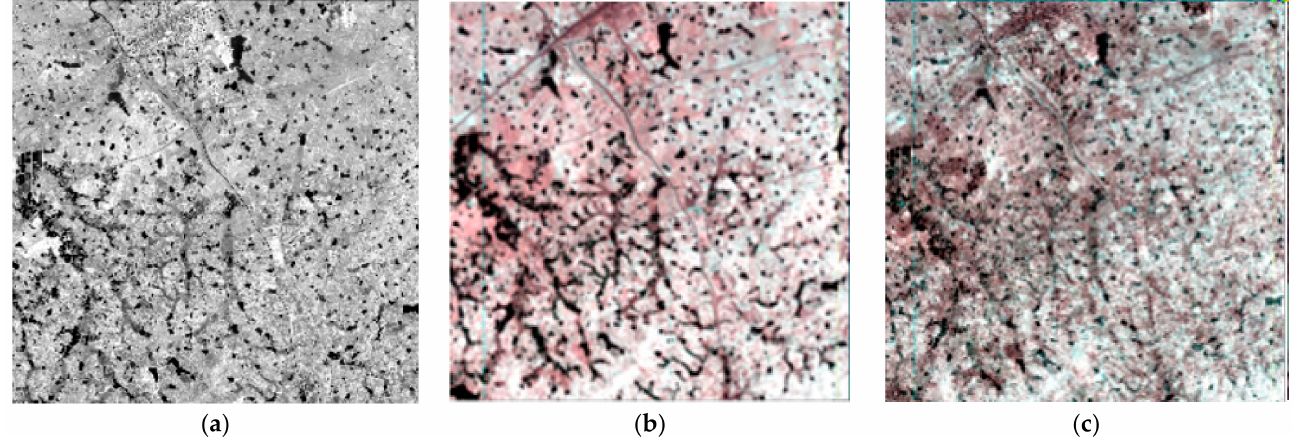
Figure 4. The Chaohu dataset: ( a ) Panchromatic image, ( b ) RGB image of hyperspectral data and ( c ) RGB image of ground truth data.